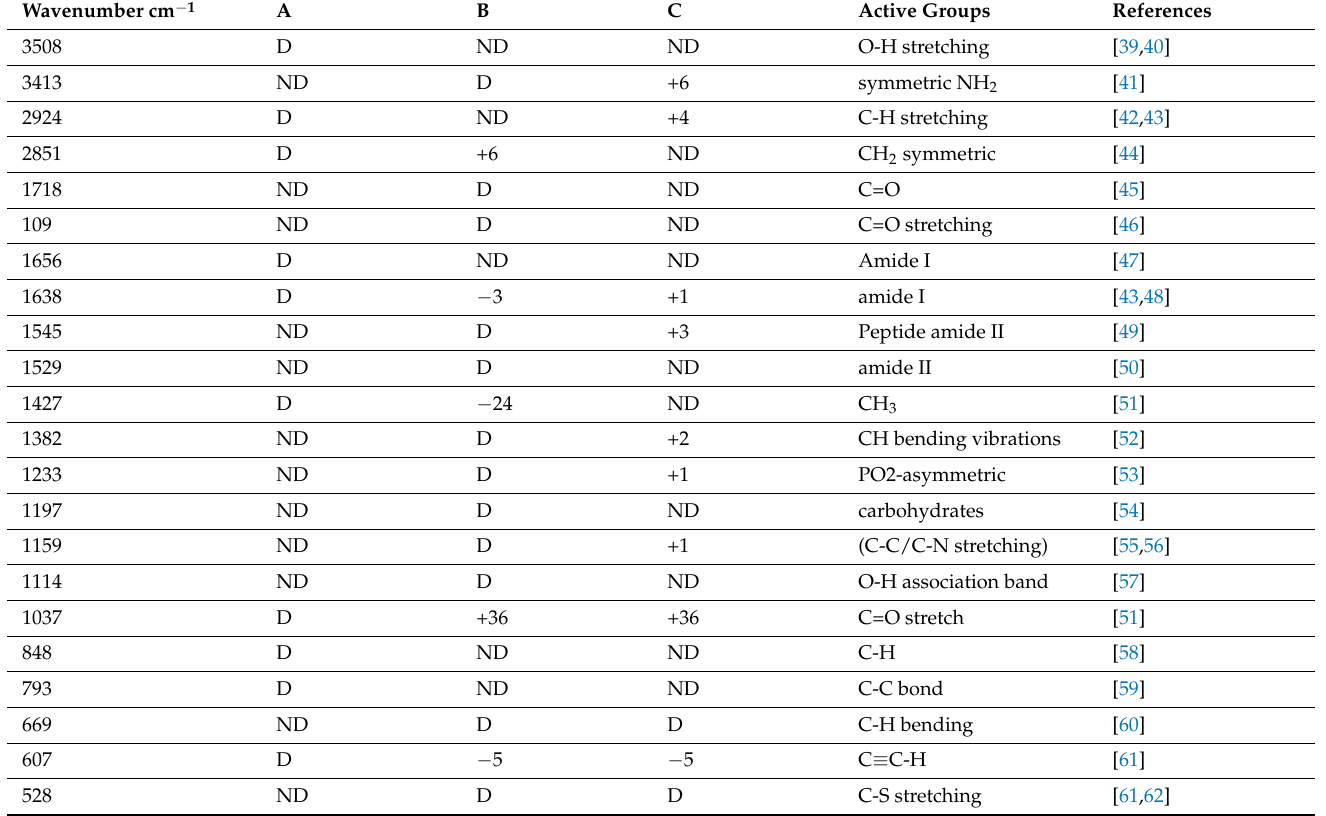
Table 1. Tabulated absorption peaks assigned to the active groups of cellulose (A), nanocellulose (B), and Ulva/Ag/cellulose nanocomposites